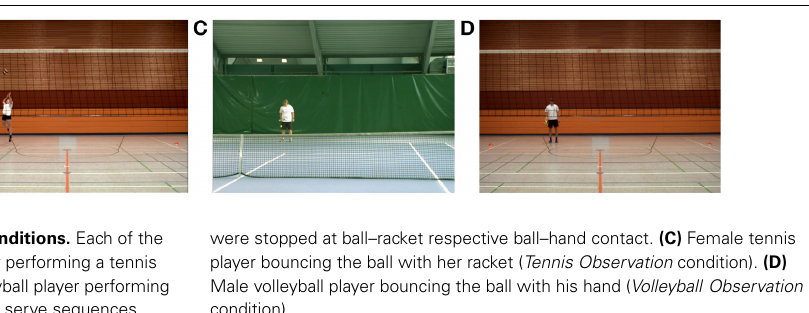
were stopped at ball–racket respective ball–hand contact. (C) Female tennis player bouncing the ball with her racket ( Tennis Observation condition). (D) Male volleyball player bouncing the ball with his hand ( Volleyball Observation